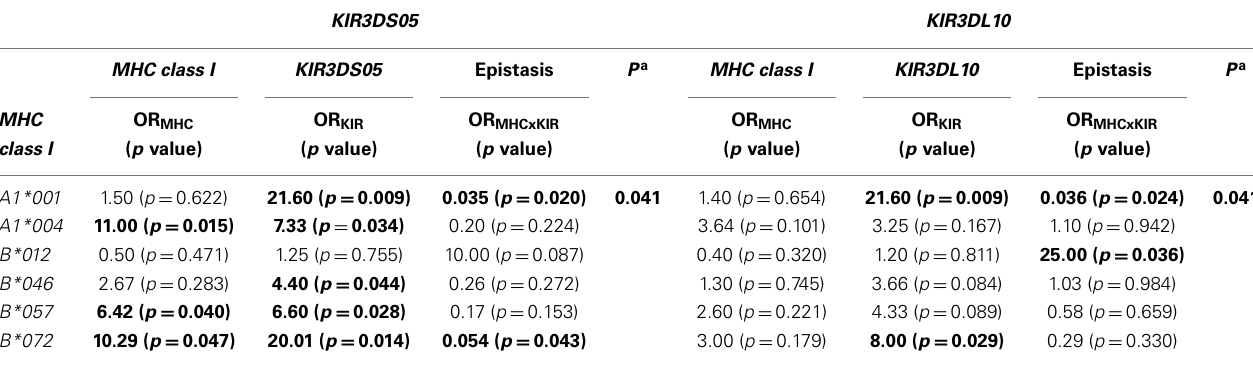
Table 4 | KIR3DS05 , KIR3DL10 epistasis with MHC class I alleles on HVL risk